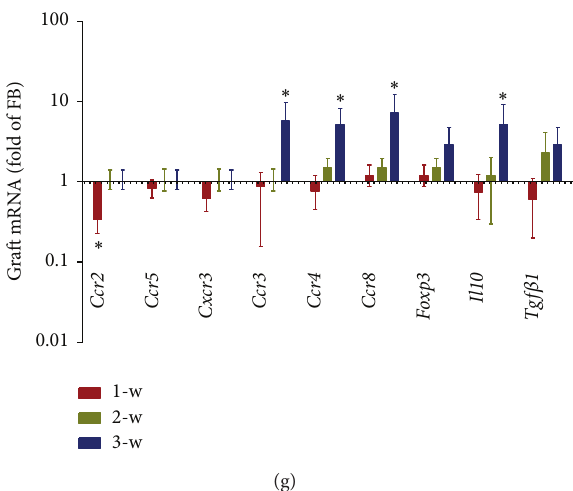
Figure 5: DSCC partially prevents infiltration of leukocytes into the allografts. Representative tissue sections of transplanted grafts of group 1 (DSCC and islets) or group 2 (FB and islets) after one week (a), two weeks (b), or three weeks (c) are presented. The insulin + or CD45 + cells are stained brown (DAB system). Isletitis grade (d) was assessed as described previously [16]. Grade 1, mononuclear infiltration, largely in the periphery, in less than 25% of the islets; grade 2, 25 to 50% of islets showing mononuclear infiltration; grade 3, over 50% of islets showing mononuclear infiltration; and grade 4, over 75%, small, retracted islets with few mononuclear cells. (e) Numbers of insulin + stained cells were calculated in three individual allografts per field. A significantly higher number of insulin + cells were in group 1 (DSCC) transplants compared with group 2 (FB) transplants at all three time points. No insulin + cells were found in group 2 transplants at three weeks after transplant. (f) Numbers of CD45 + stained cells were calculated in three individual allografts per group. (g) Kinetics of mRNA expression for Th1 ( Ccr2 , Ccr5 , and Cxcr3 ) chemokines, Th2 ( Ccr3 , Ccr4 , and Ccr8 ) chemokines, Foxp3 , Il10 , and Tgf 𝛽 1 was detected by quantitative real-time PCR in the allografts from group 1 (DSCC) and group 2 (FB) after one week (in red), two weeks (in green), and three weeks (in blue) of transplantation. (d), (e), and (f) were generated from 3 individual mice per group. (g) represents the results from three different mice with duplicated repeats, with Student 𝑡 -test showing significance, ∗ 𝑃 < 0.05